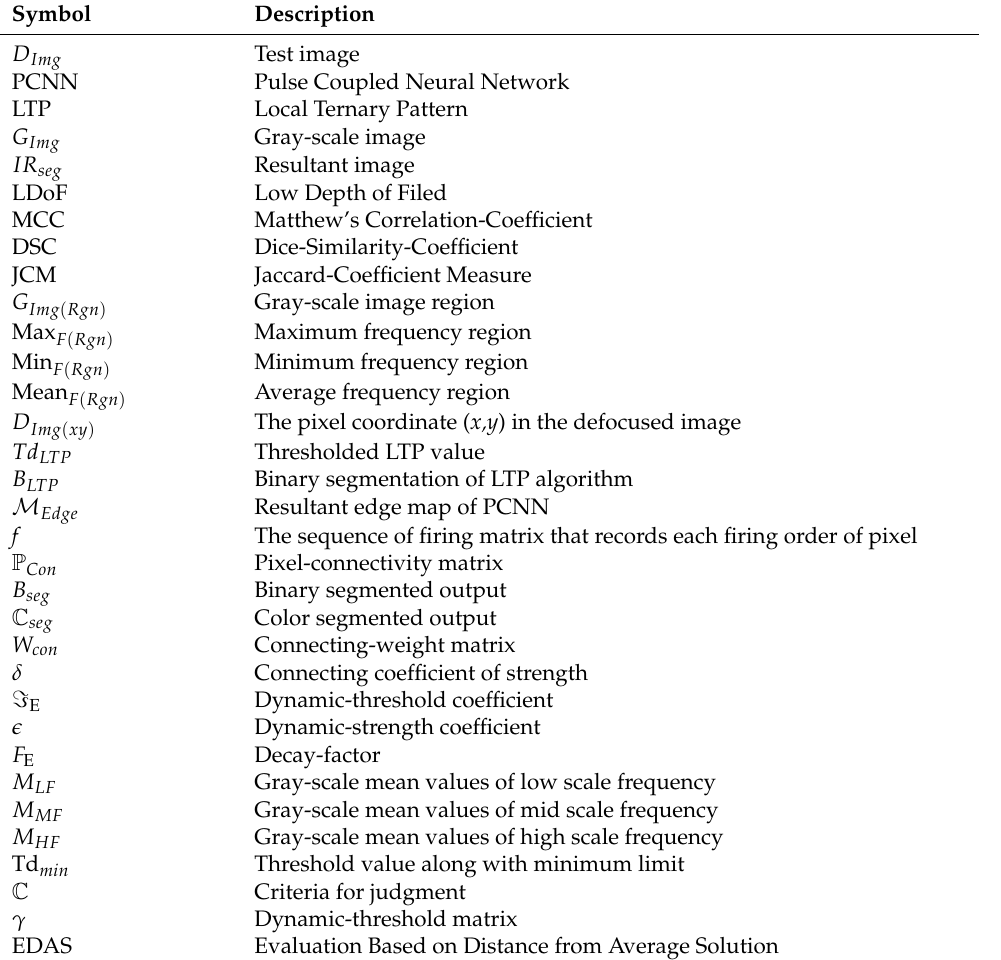
Table 2. Symbols and descriptions used in our